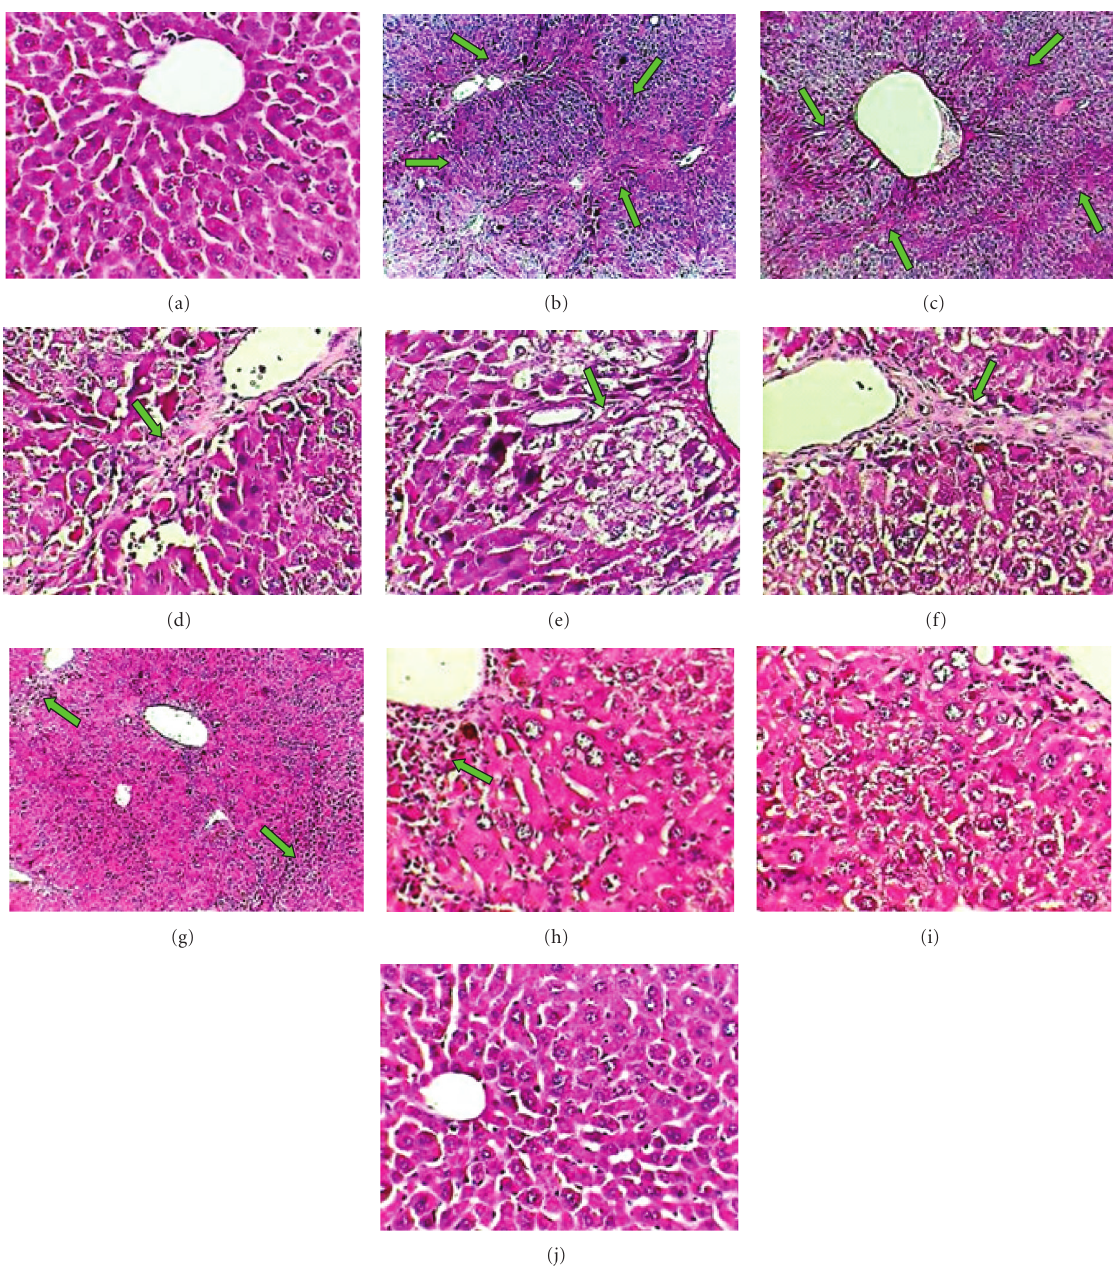
Figure 1: Photomicrographs of liver sections of normal control mice ((a), × 400) showing normal histological structure; TAA-treated mice ((b) and (c), × 100; (d), (e), and (f), × 400) showing severe damage of liver structure including the formation of pseudolobules with fibrotic septa (arrows); TAA plus G . biloba leaves extract-treated mice ((g), × 100; (h) and (i), × 400) showing disarrangement of hepatic strands and few of fibrotic septa (arrows); G . biloba leaves extract-treated mice ((j), × 400) showing normal histological structure.